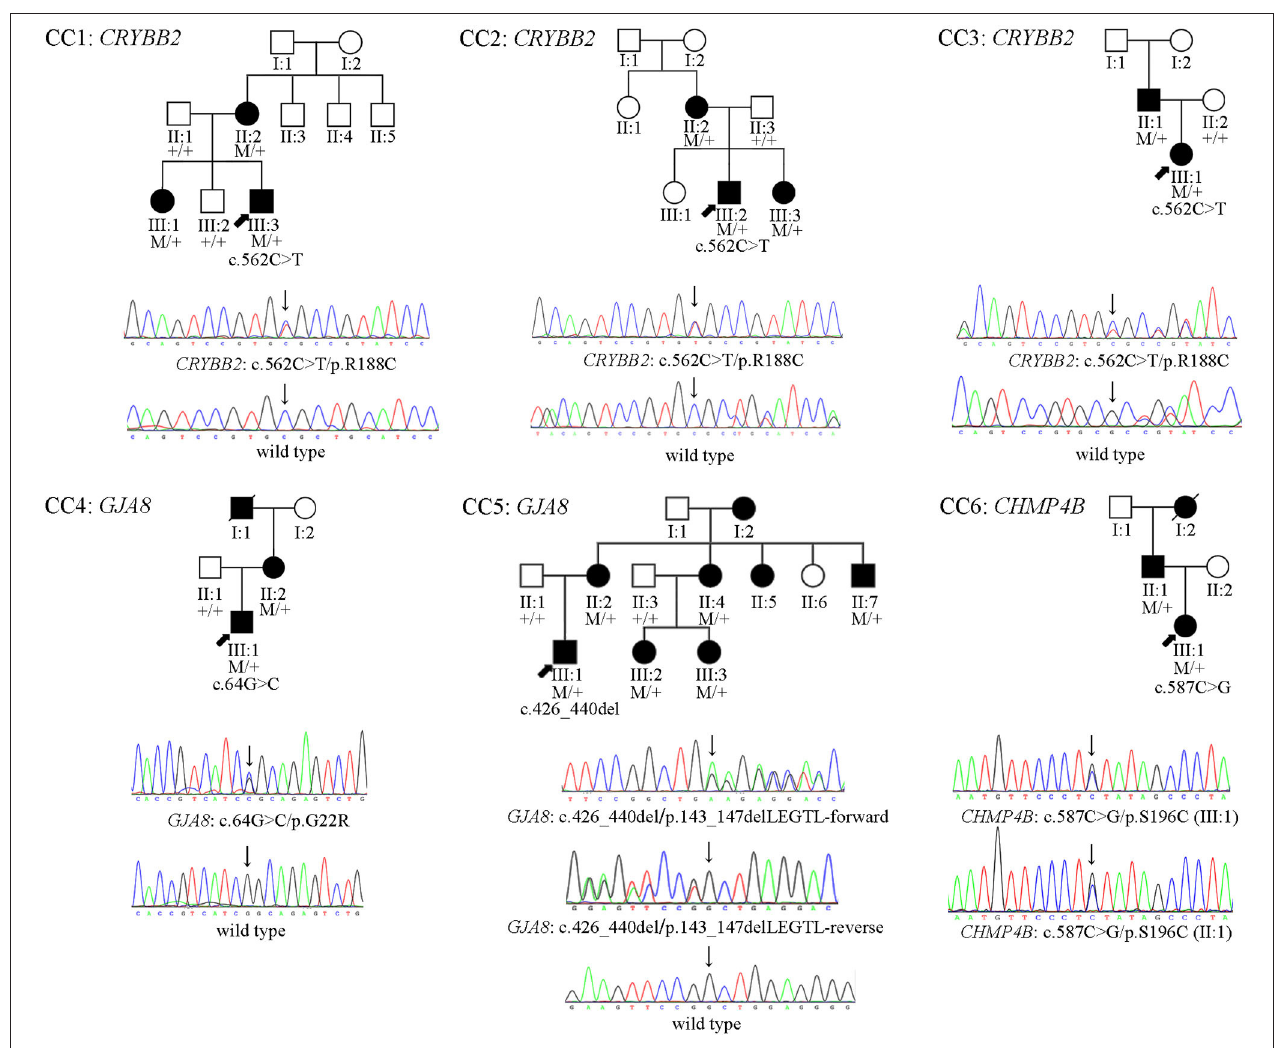
FIGURE 1 | The pedigrees, and cosegregation analyses and sequence maps of six Chinese Han families of CCs. In family CC1–CC5, the sequence maps are for the probands and their unaffected parents. In family CC6, the sequence map is for the proband and her affected